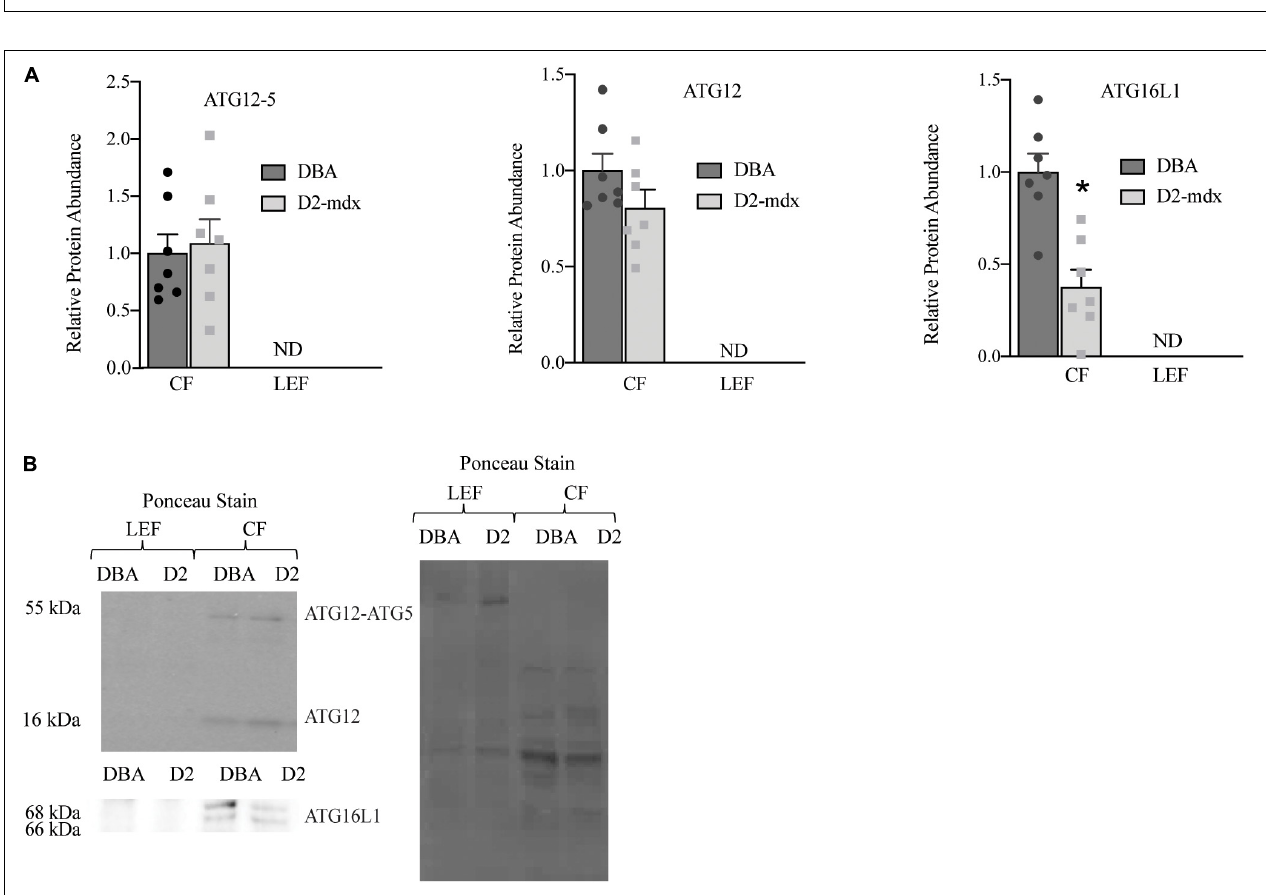
FIGURE 4 | Autophagosome formation markers were detected only in cytosolic fraction from gastrocnemius muscles. Western blot analysis of ATG16L1, ATG12-ATG5, and ATG12 in cytosolic fraction of gastrocnemius muscles from 11 mo DBA and D2-mdx mice. (A) ATG16L1 was decreased in CF from D2-mdx compared to DBA and ATG12 and ATG12-ATG5 were similar between the groups. (B) Representative western blot images and corresponding Ponceau stain image. Significance is established at p < 0.05. * Indicates significance in D2-mdx and DBA ( n = 7 mice per group). ND indicates not detected.